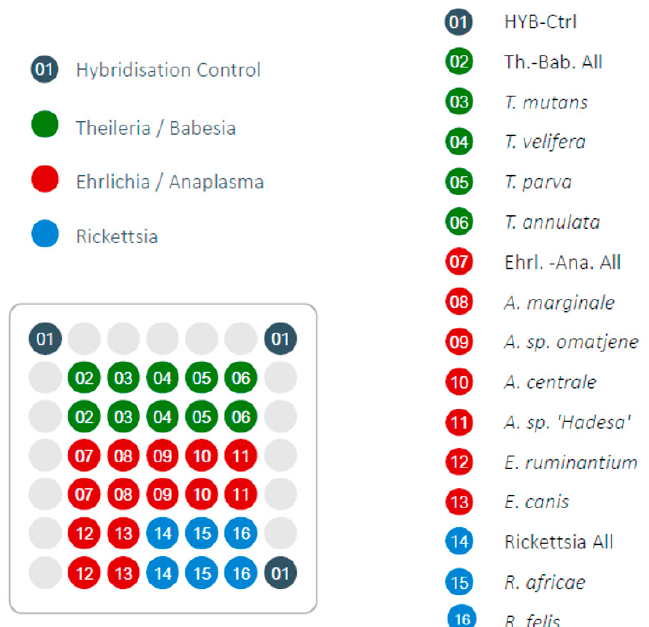
Figure 1. Design of LCD-Array for tick-borne pathogens indicating the screened species and genera. Light grey circles are blank positions.